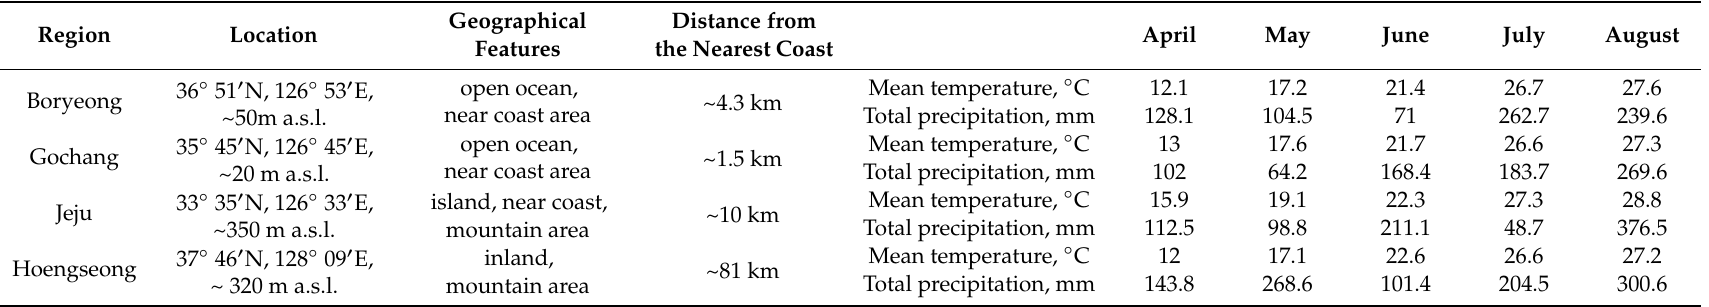
Table 1. Brief descriptions of geographical location, features, and climatic factors of four representative organic milk (OM) production regions in Korea. Geographical Distance from Region Location Features the Nearest